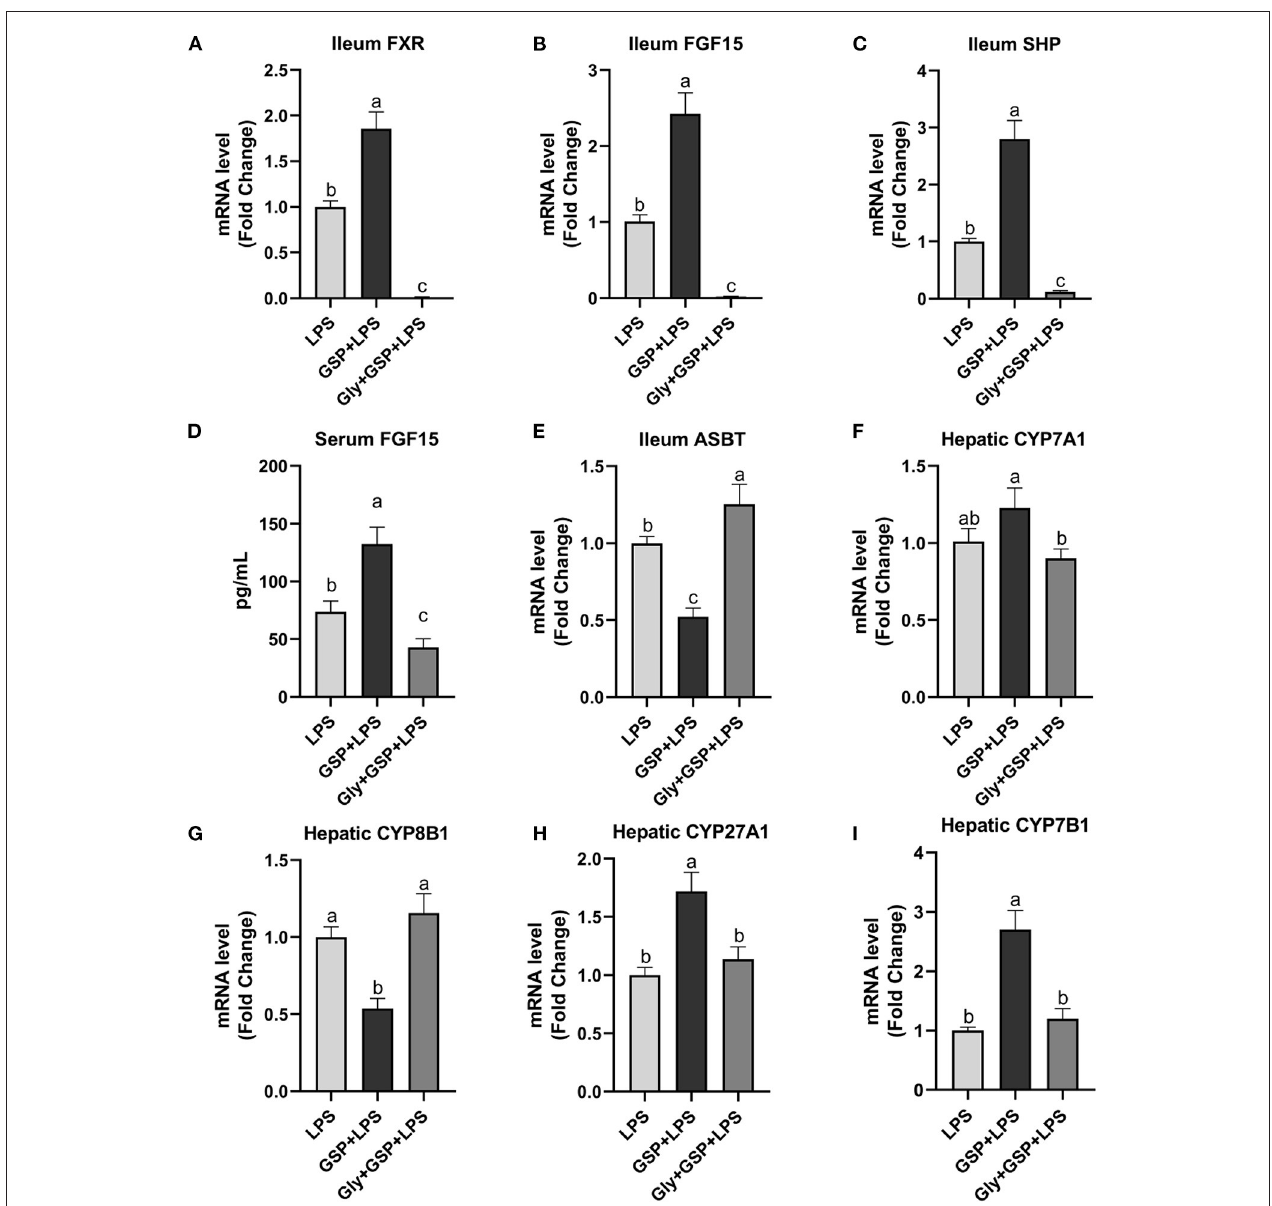
FIGURE 6 | The intestinal farnesol X receptor (FXR) activity and the expression of genes involved in bile acid recirculation in C57BL/6 mice with different treatments in experiment 2. (A,B) Gene expression levels of FXR and fibroblast growth factor 15 (FGF15) in the ileum. (C) Gene expression level of SHPs in the ileum. (D) Serum FGF15. (E) Gene expression level of apical sodium-dependent BA transporter (ASBT) in the distal ileum. (F–I) Gene expression levels of cytochrome P450 7A1 (CYP7A1), CYP8B1, CYP27A1, and CYP7B1 in the liver. LPS, a LPS injection group that oral gavaged with physiological saline before i.p. LPS injection; GSP + LPS, a GSP administration group that oral gavaged with 250 mg/kg GSP before i.p. LPS injection; Gly + GSP + LPS, the GSP + LPS group coupled with a dose of 10 mg/kg BW glycine- β -muricholic acid. Data are presented by the mean ± SEMs ( n = 6). Bars with no letter in common are significantly different, p ≤